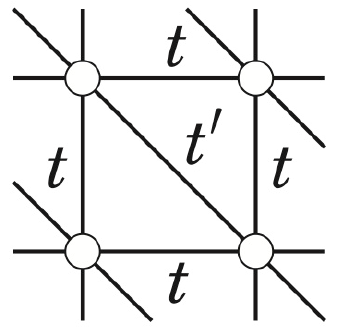
Figure 3. Transfer integrals in triangular lattices, t and t'